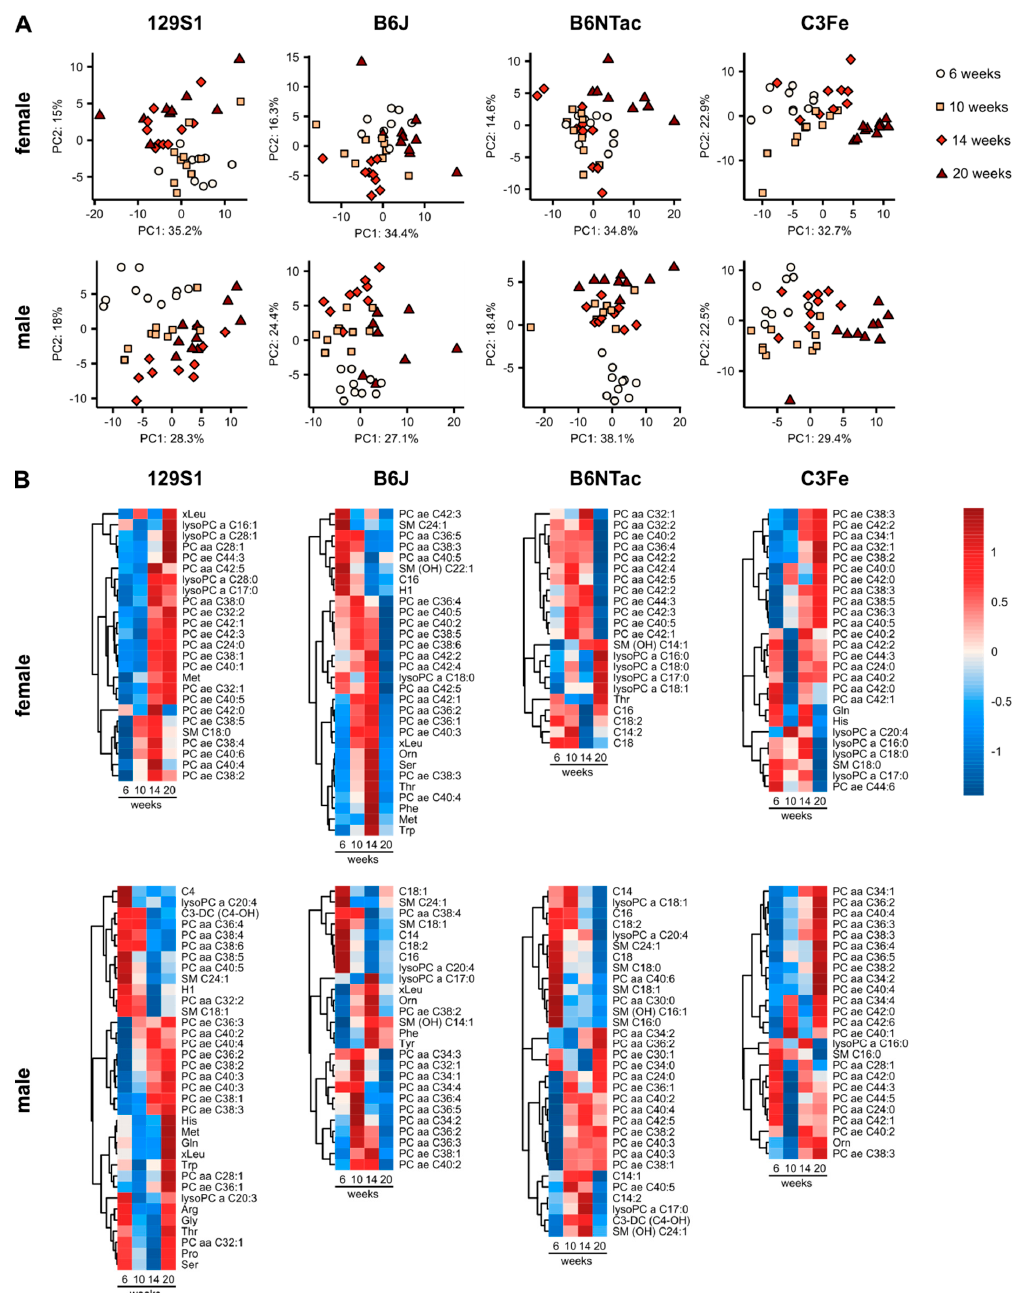
Figure 1. Age-dependent metabolomic changes in murine plasma. ( A ) PCA of metabolomics data at 6, 10, 14, and 20 weeks of age. ( B ) Heatmaps of z scores of top metabolites distinguishing between age. Metabolites were selected based on loading scores of principle components 1 to 3 in PCA and the mean decrease in accuracy in random forest analysis. Z scores were calculated from scaled and centered mean metabolite concentrations. Analyses were performed for each mouse strain separately. Ester (a) and ether (e) bonds linking the fatty acids to the glycerol moiety are specified in the metabolite labels: acyl (a), diacyl (aa), acyl alkyl